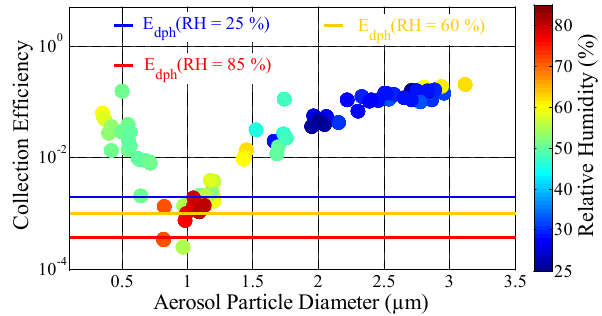
Figure 9. Collection efficiencies measured for drops of 2mm in Figure 1. Collection efficiencies measured for drops of 2 mm in diameter as a function of relative diameter as a function of relative humidity, and comparison with the humidity, and comparison with the model of Davenport and Peters (1978), a semi-empirical model of Davenport and Peters (1978), a semi-empirical correlation correlation to evaluate diffusiophoretic elementary collection efficiency to evaluate diffusiophoretic elementary collection